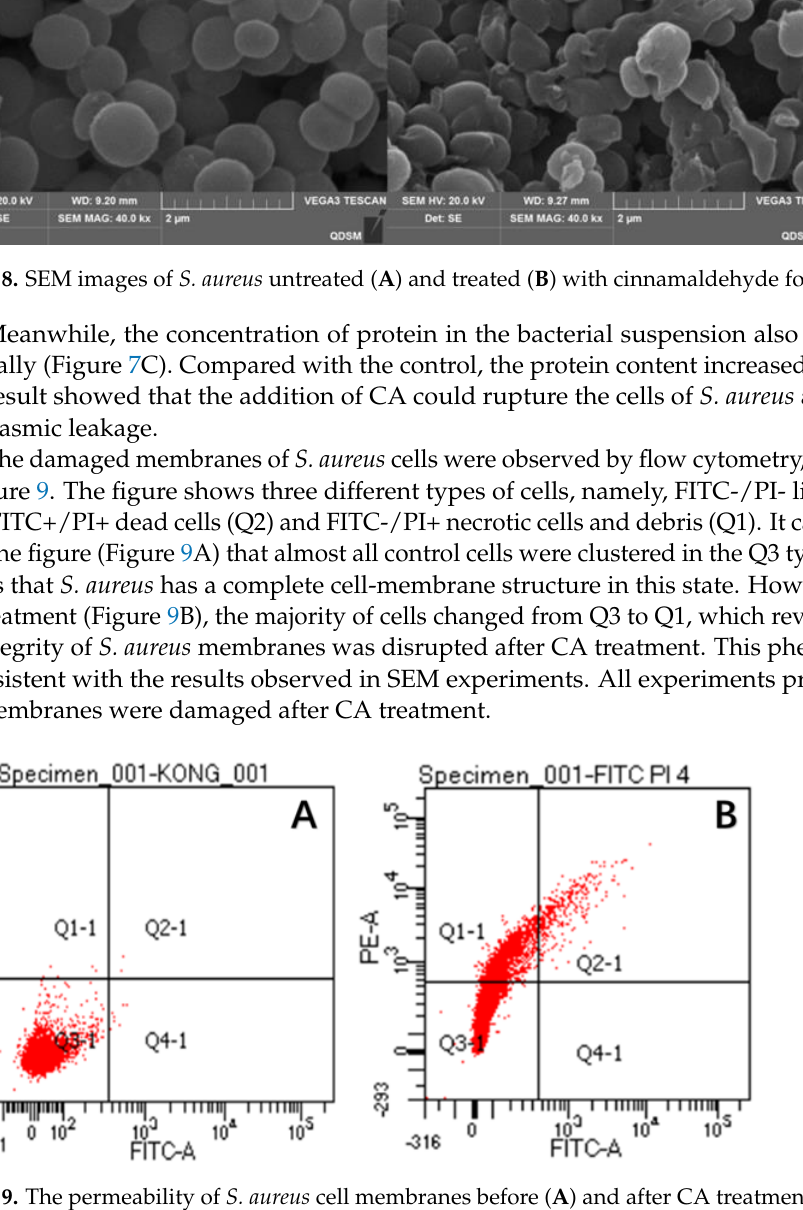
Figure 9. The permeability of S. aureus cell membranes before ( A ) and after CA treatment ( B ).